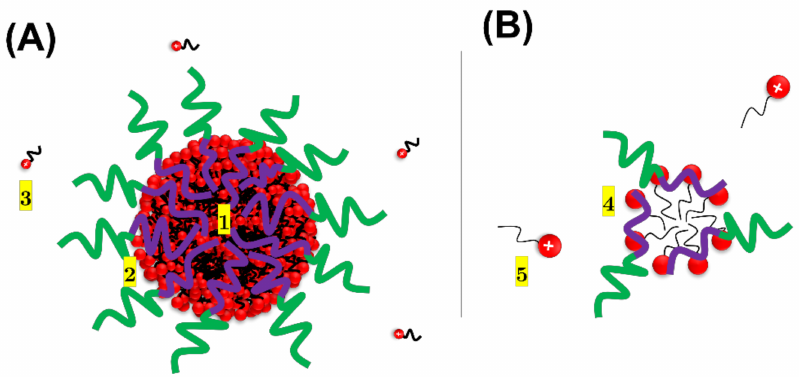
Figure 6. Schematic illustration of distinguishable populations of surfactant ions in BCPCS particle dispersions: ( A ) large particles (predominating in intact samples and concentrated phases) with a dense liquid crystalline core formed by surfactant micelles surrounded by the polyion chains; ( B ) small aggregates (predominating in dilute phases) formed by aggregated surfactant ions neutral- ized by a few polyion chains. In ( A ), the sites labeled as 1, 2, and 3 correspond to the core, surface, and free (dissociated) surfactant ions, respectively. The exchange between the core and surface surfactant ions is slow, whereas the exchange between the surface and free surfactant ions is fast. In ( B ), the sites labeled as 4 and 5 correspond to the surface and free surfactant ions, which undergo a fast exchange. In both cases, the aggregate shape is arbitrarily depicted as spherical. Green, purple, red, and black segments denote the PAAm block, the PA block, the surfactant headgroup, and the surfactant alkyl chain,